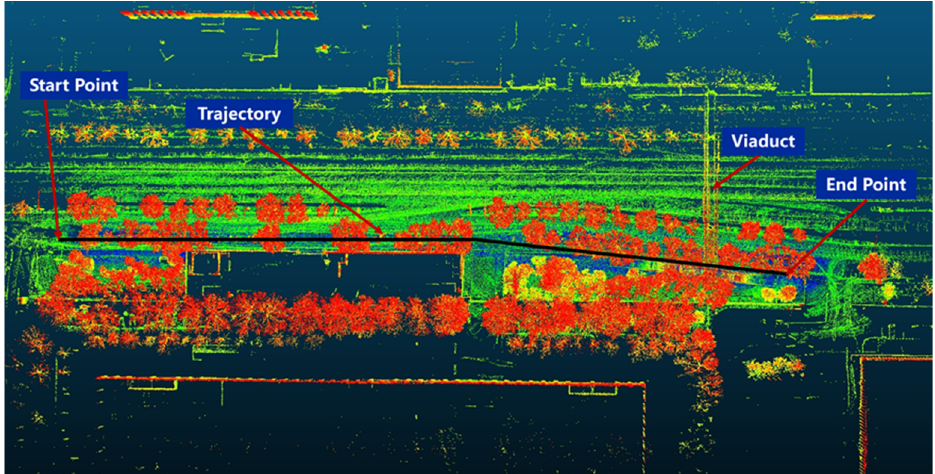
Figure 7. Three-Dimensional LiDAR global point cloud map in case one.